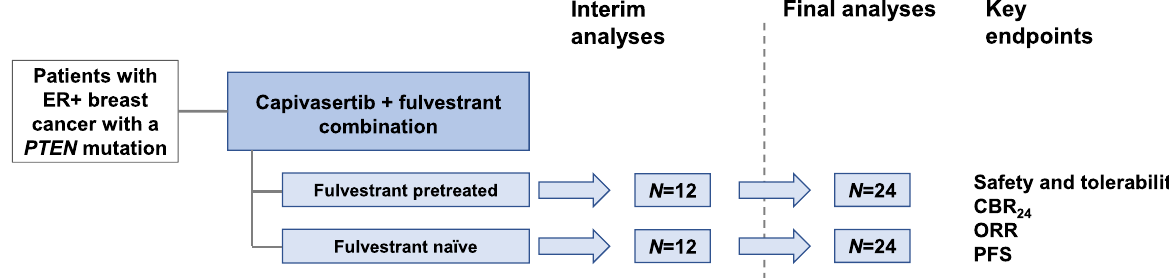
Fig. 3 Study design of the PTEN -mutant breast cancer cohort. Up to 24 patients in each cohort. Interim analyses were carried out after 12 patients were followed up for 24 weeks or withdrawn from the study. Subsequent patients were recruited only if suf fi cient antitumor activity (assessed by CBR 24 ) was observed at the interim analyses. CBR 24 clinical bene fi t rate at 24 weeks, ER + estrogen-receptor-positive, ORR objective response rate, PFS progression-free